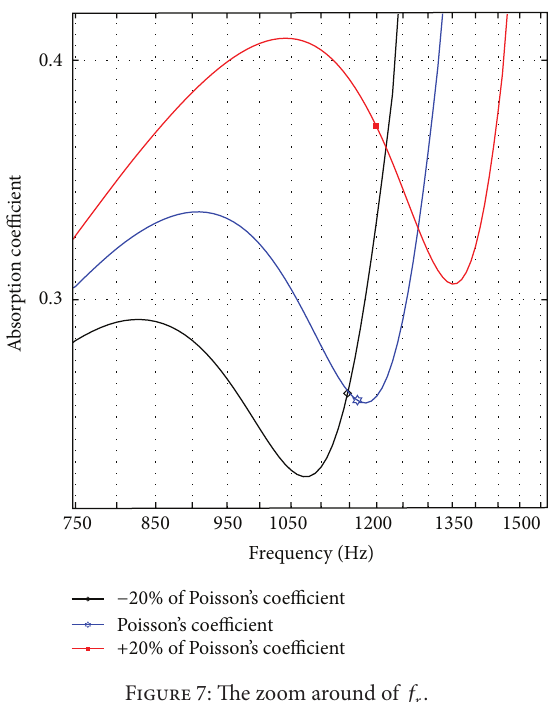
Figure 9: The zoom around of 𝑓 𝑟 .